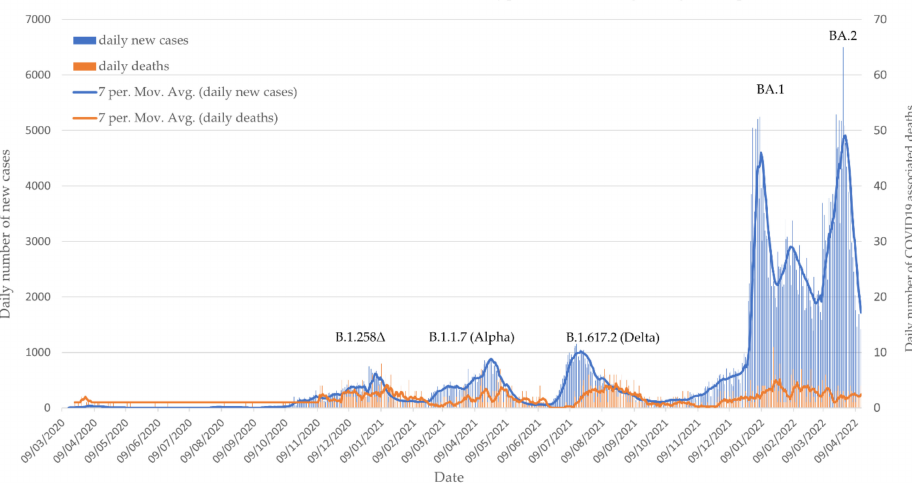
Figure 1. Number of daily positive SARS-CoV-2 cases as well as the number of